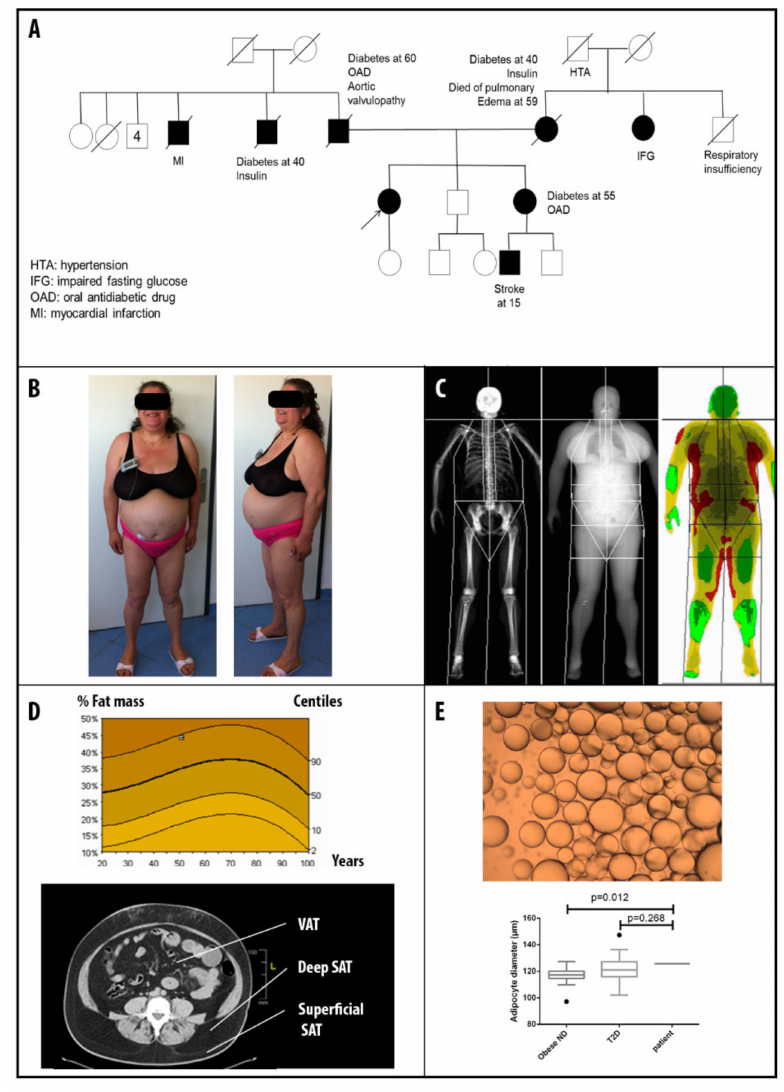
Figure 1. Patient 1 clinical description. ( A ) Pedigree of patient 1 family, ( B ) Photographs of patient 1 showing central / android shape obesity with fat accumulation in the facial and supraclavicular regions, and cushingoid morphotype. ( C ) Dual energy X-ray absorptiometry (DEXA) showing body fat distribution. ( D ) Percentage of fat mass compared to the reference curve and abdominal computed tomography (CT) scan confirming the presence of a small amount of subcutaneous adipose tissue (SAT) (superficial and deep), and an excessive accumulation of visceral adipose tissue (VAT). ( E ) Needle fat biopsy showing the same adipocytes diameter as a type 2 diabetic population matched for age, sex, and body mass index (BMI) and higher adipocytes diameter than obese non diabetic (ND) population matched for age, sex and